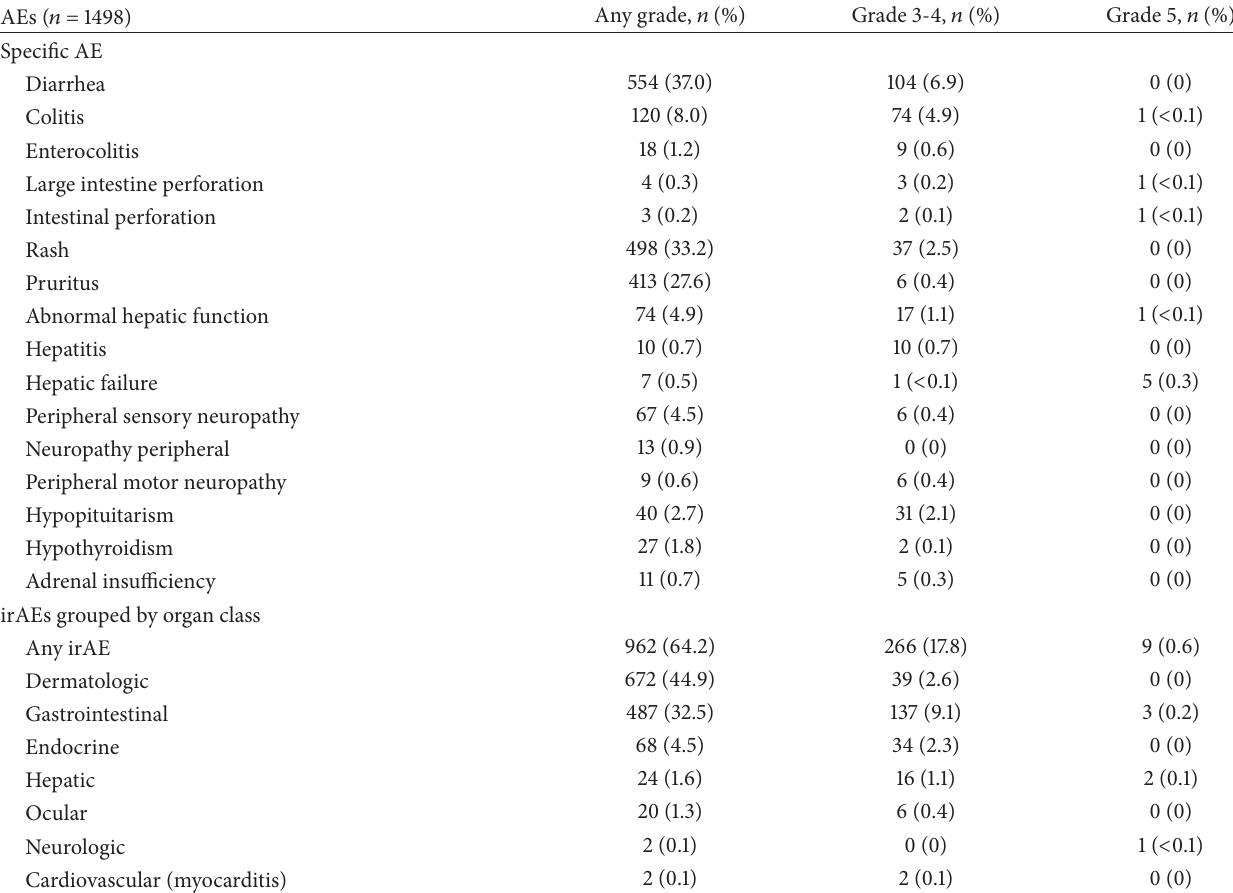
Table 2: Frequency of specific AEs ∗ and irAEs in a pooled analysis of 1498 patients in phase I–III studies of ipilimumab in unresectable stage III or stage IV melanoma